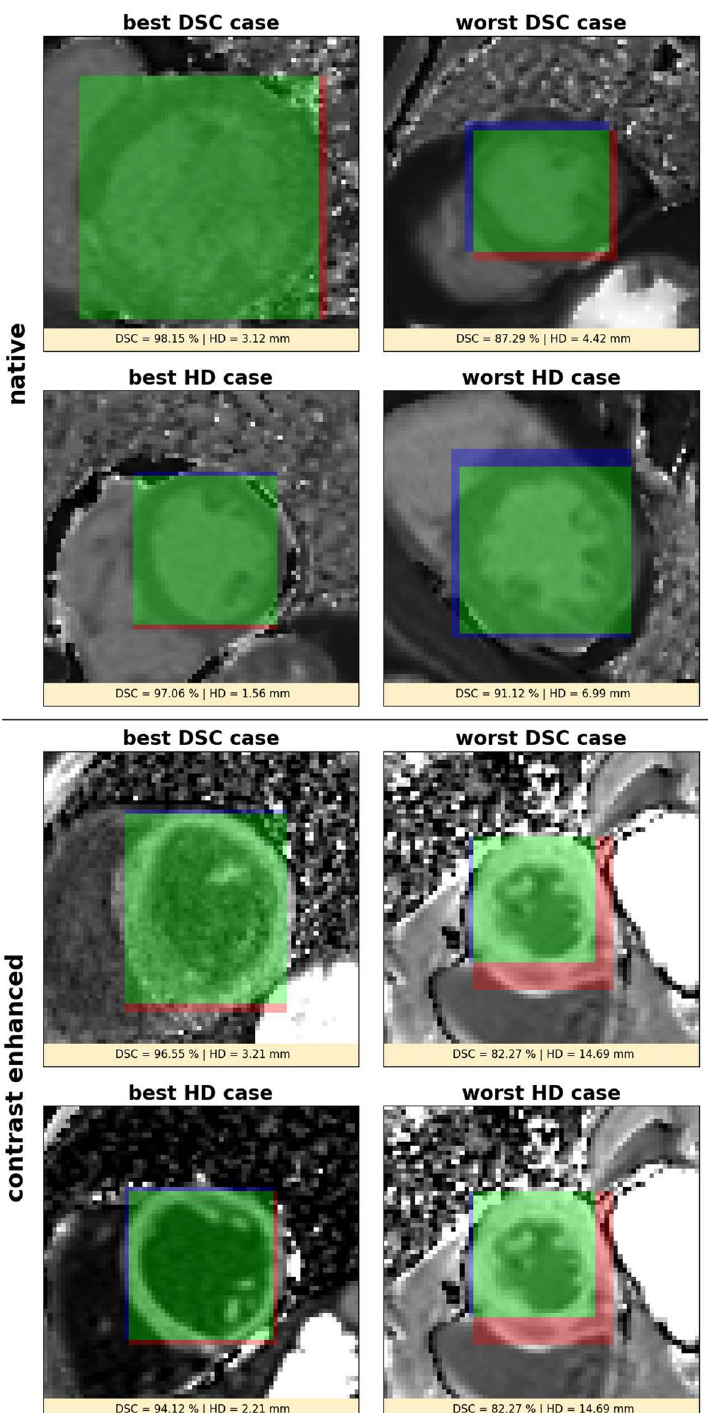
Figure 2. Example results of the object detection algorithm showing bounding boxes for the left ventricular myocardium. The upper block corresponds to native and the lower block to contrast enhanced data; respectively in each block the first row corresponds with respect to the Dice Similarity Coefficient (DSC) and the second row corresponds with respect to the Hausdorff Distance (HD) while the first column shows the best and the second column the worst case. Green denotes true positive, blue false negative and red false positive segmented bounding box